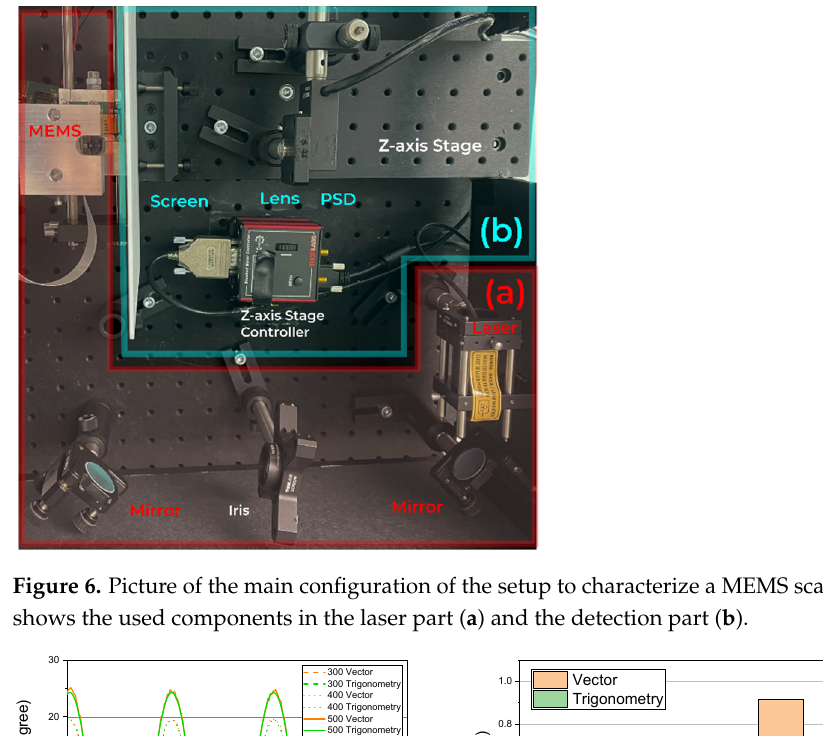
Figure 6. Picture of the main configuration of the setup to characterize a MEMS scanner. The overlay shows the used components in the laser part ( a ) and the detection part ( b ).